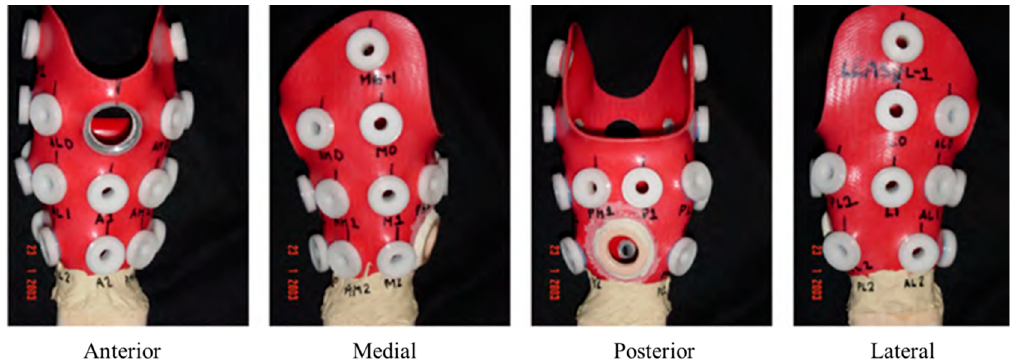
Figure 8. Locations of SG-based transducers on PTB socket [16].